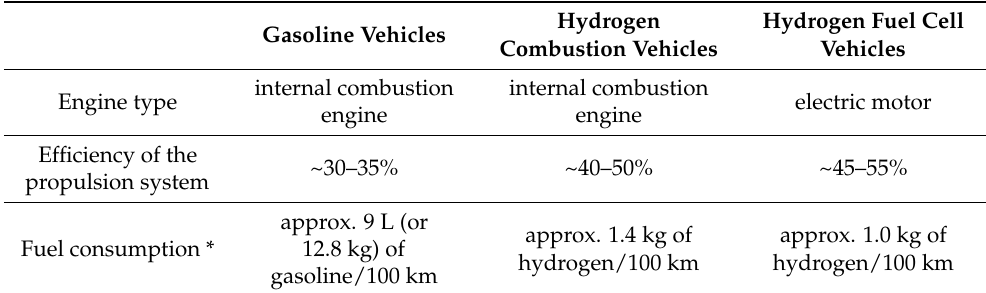
Table 1. Comparison of the basic parameters of conventional gasoline vehicles, hydrogen combustion vehicles and vehicles powered by hydrogen fuel cells